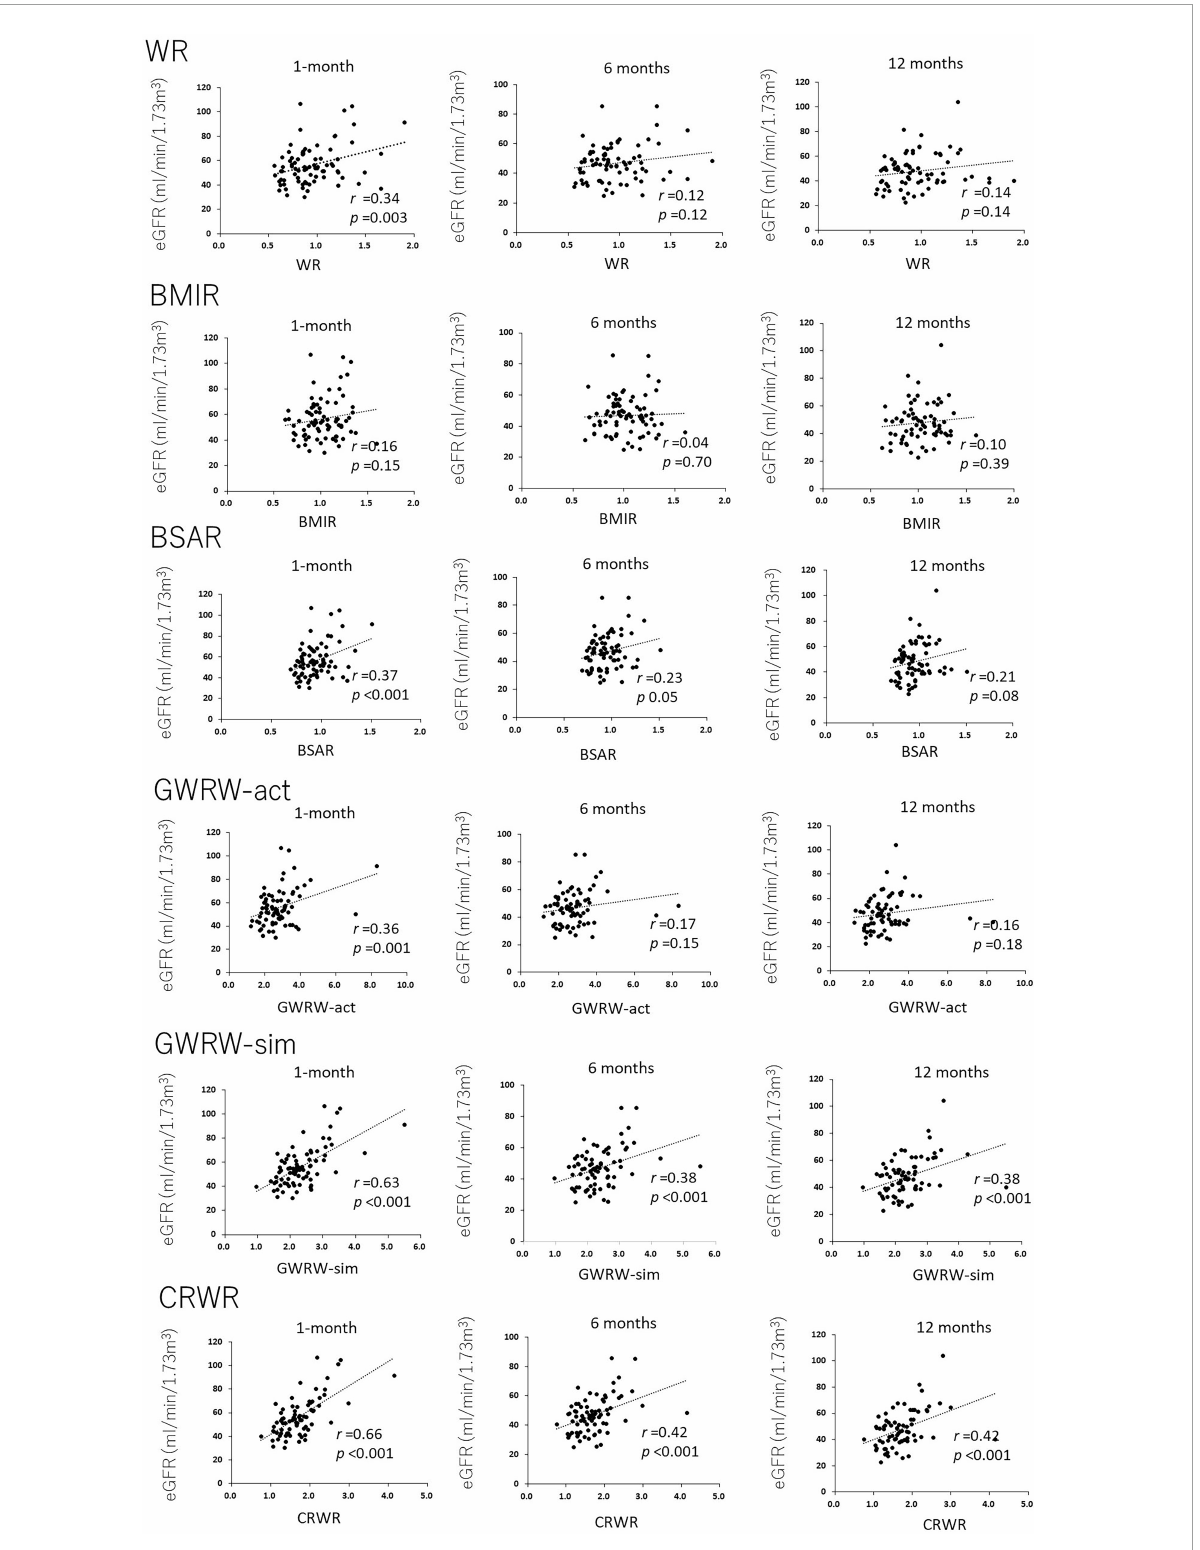
FIGURE2 Correlation of donor-recipient size mismatch parameters (WR, BMIR, BSAR, GRWR-act, GRWR-sim, and CRWR) with renal function at 1, 6, and 12 months posttransplantation. The correlation coefficients for CRWR were the highest among the other size mismatch